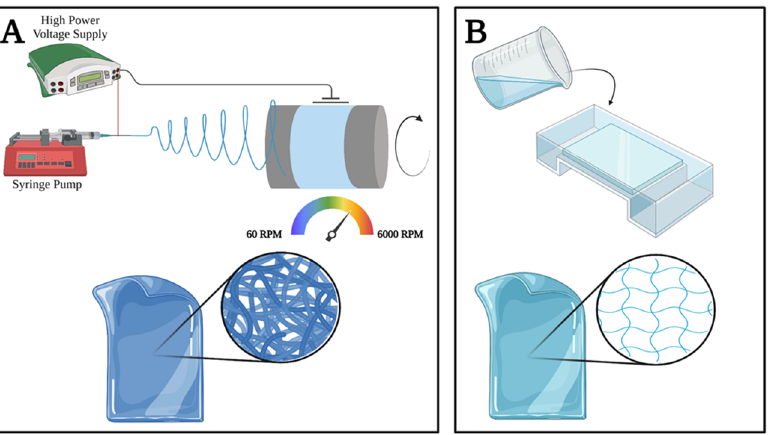
Figure 1. Preparation of poly(vinyl-alcohol) electrospun membranes ( A ) and bulk hydrogels ( B